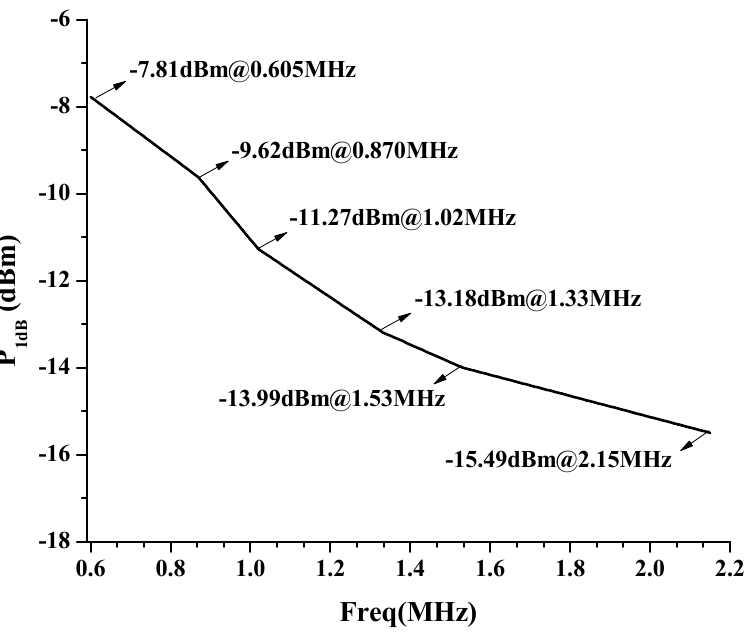
Figure 10. Measured input P 1dB versus different bandwidths.